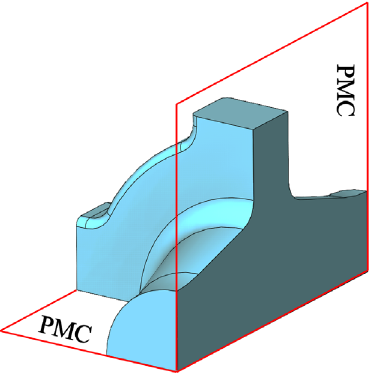
FIG. 3. Vacuum space of a quarter section of the coupler cross, showing the two PMC symmetry planes used to eliminate higher modes in the overmoded cylindrical